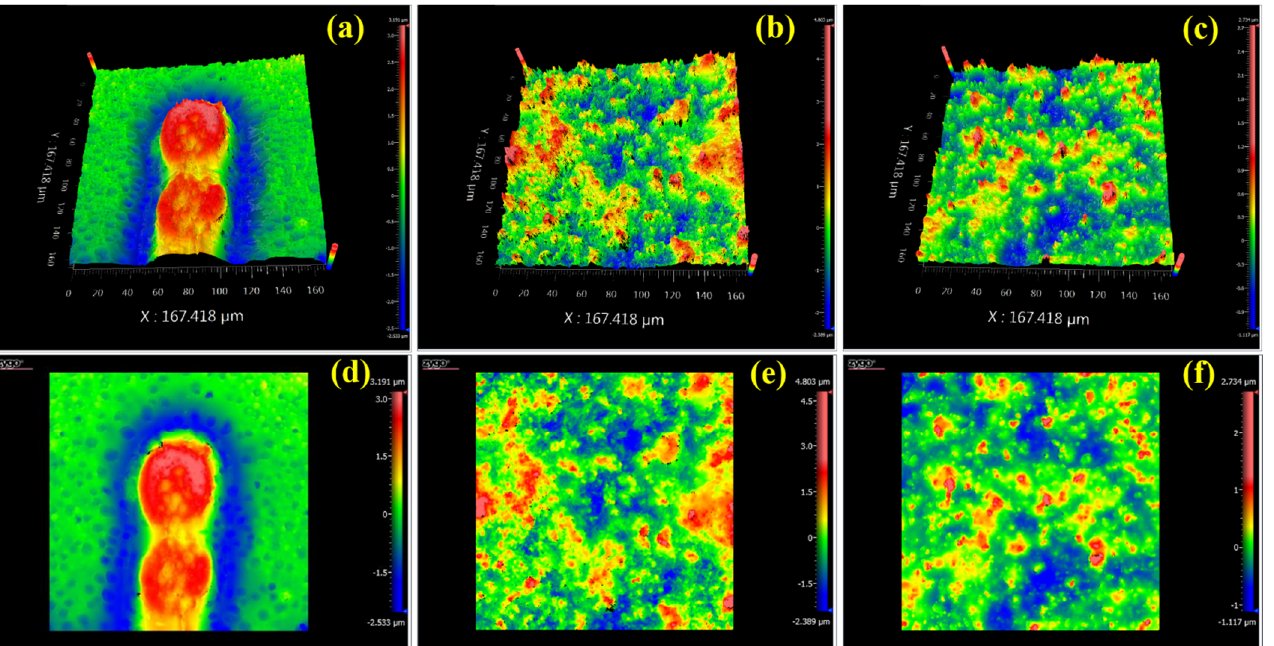
Figure 6. 3D and 2D Optical surface profiler of PVAm ( a , d ), PVAm-UiO-66-NH 2 ( b , e ) and PVAm-PVA-UiO-66-NH 2 ( c , f ).